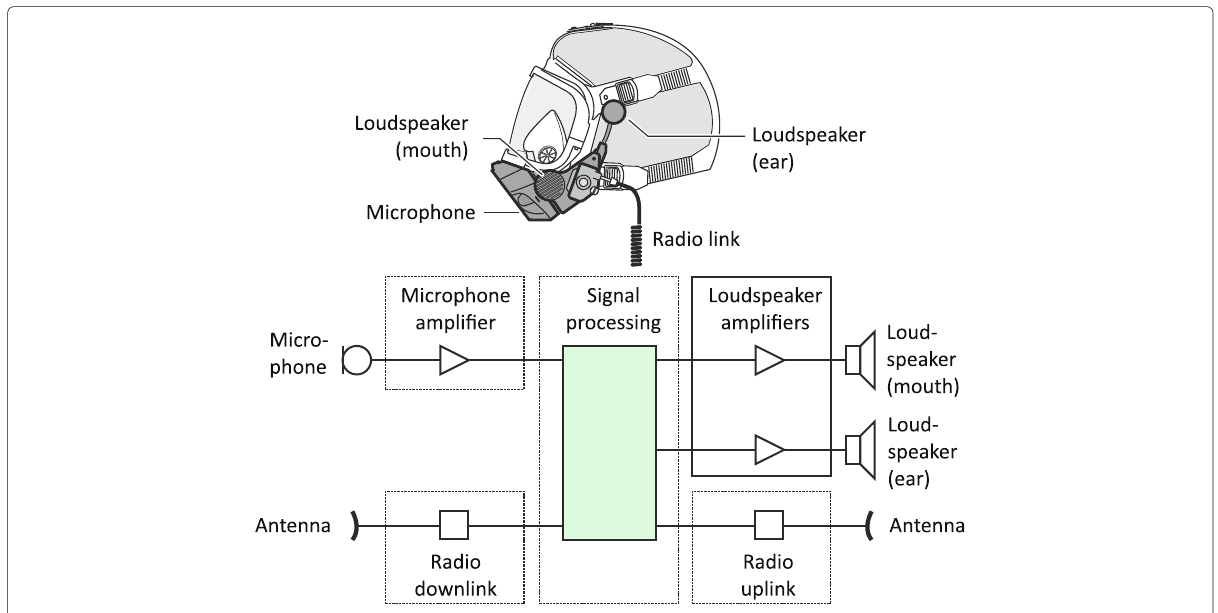
Fig. 4 Structure of the communication